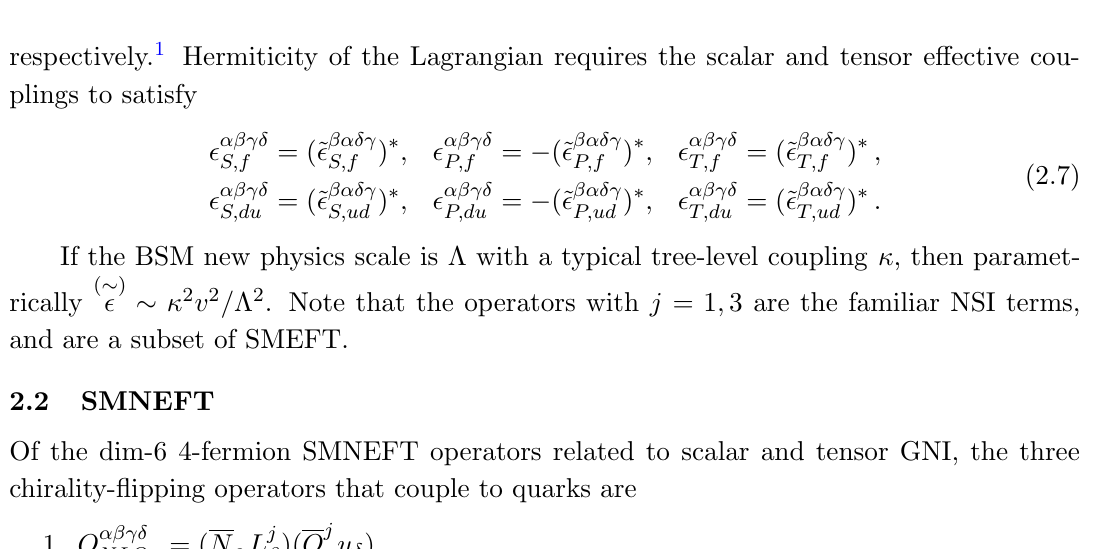
Table 1. E(cid:11)ective coupling constants and